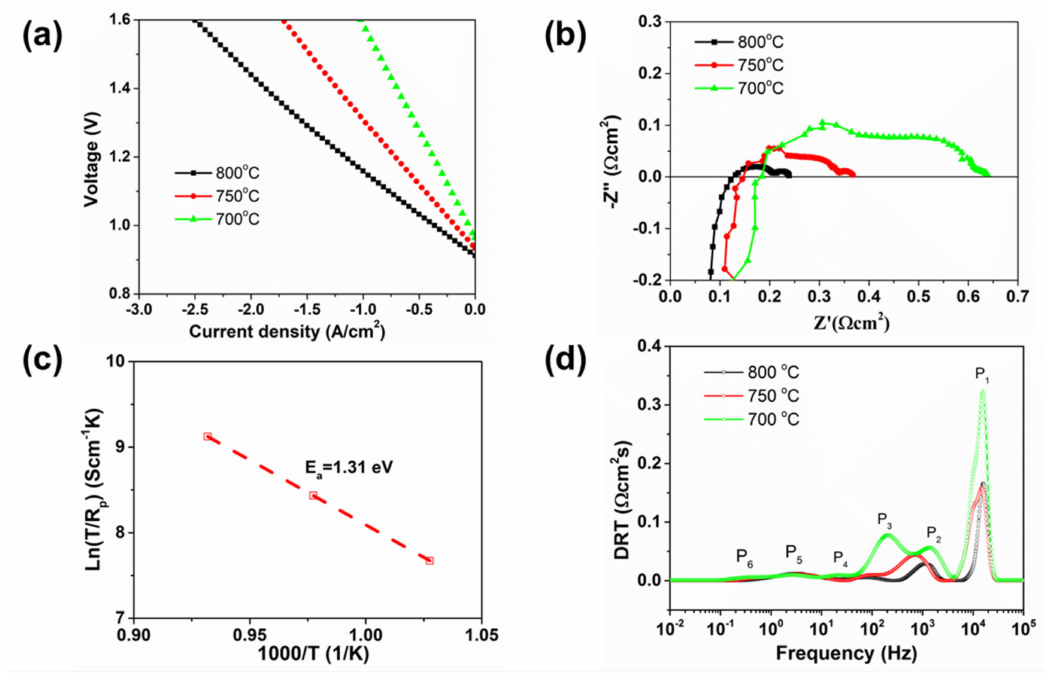
Figure 4. ( a ) I–V charge curves, ( b ) the impedance spectra, ( c ) the activation energy for the polarization process and ( d ) the DRT analysis of the impedance spectra for CO 2 electrolysis at 700–800 ◦